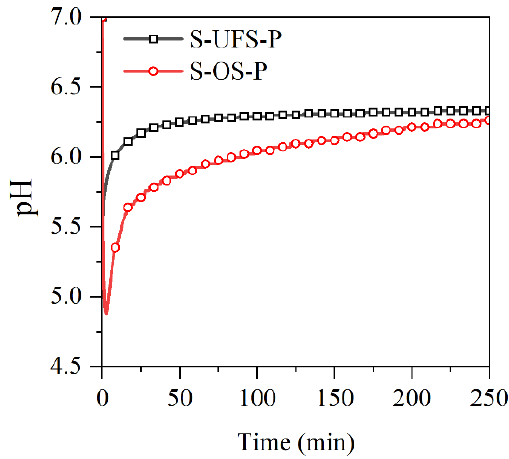
Figure 10. pH curves of the slag/KH 2 PO 4 suspensions.